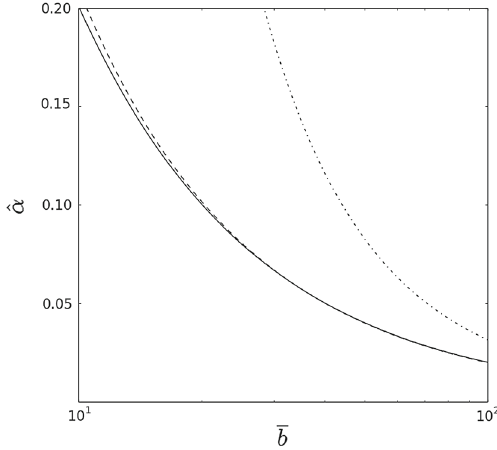
/ω 2 = 0 . 5. Note the scale used f